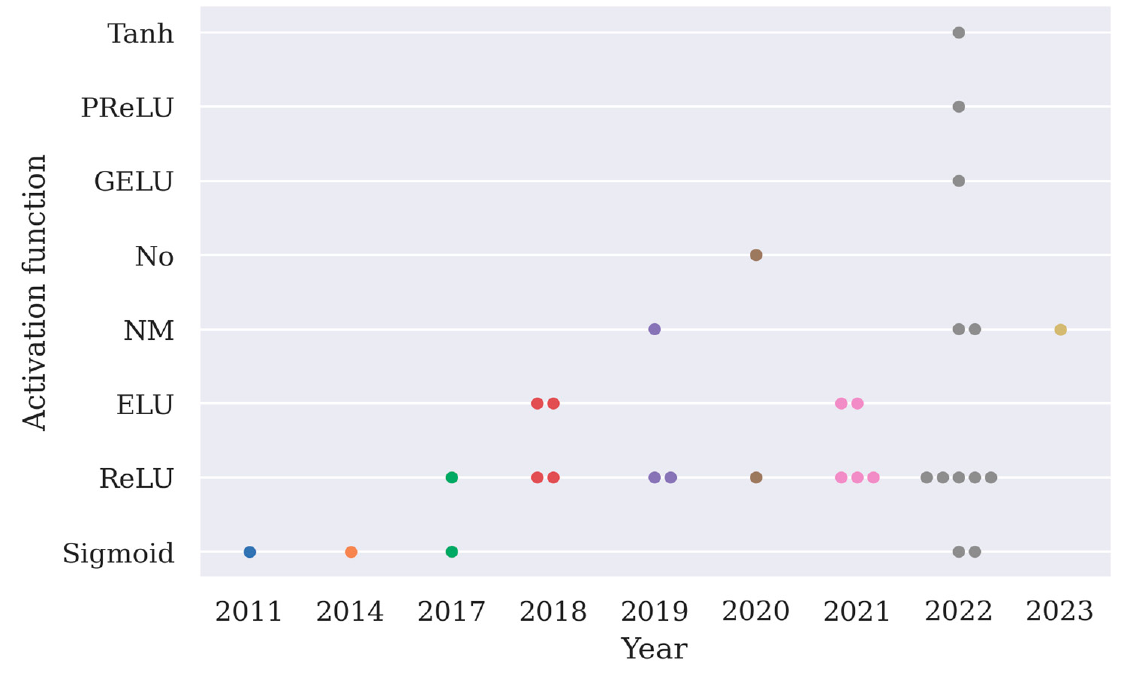
Figure 4. A summary of different types of activation functions used in 31 deep learning models as shown in Table 2 (PReLU stands for parametric rectified linear unit, GELU stands for Gaussian error linear unit, ELU stands for exponential linear unit, No means an activation function is not used in the model).